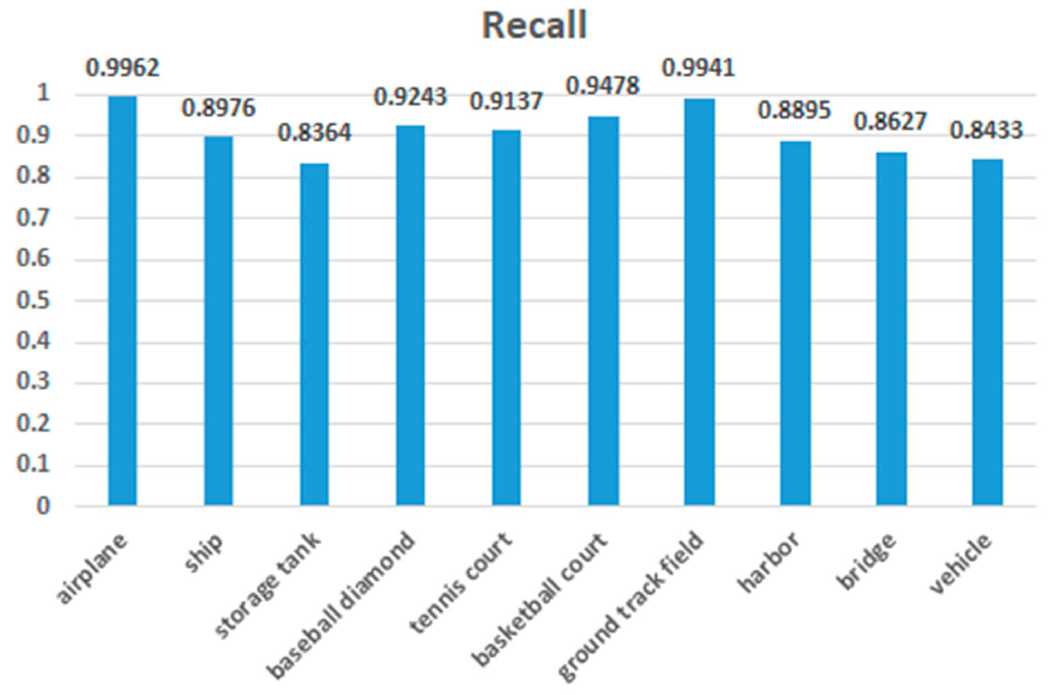
Figure 7. The loss curve and fitted curve of Multi-stage FEPN.